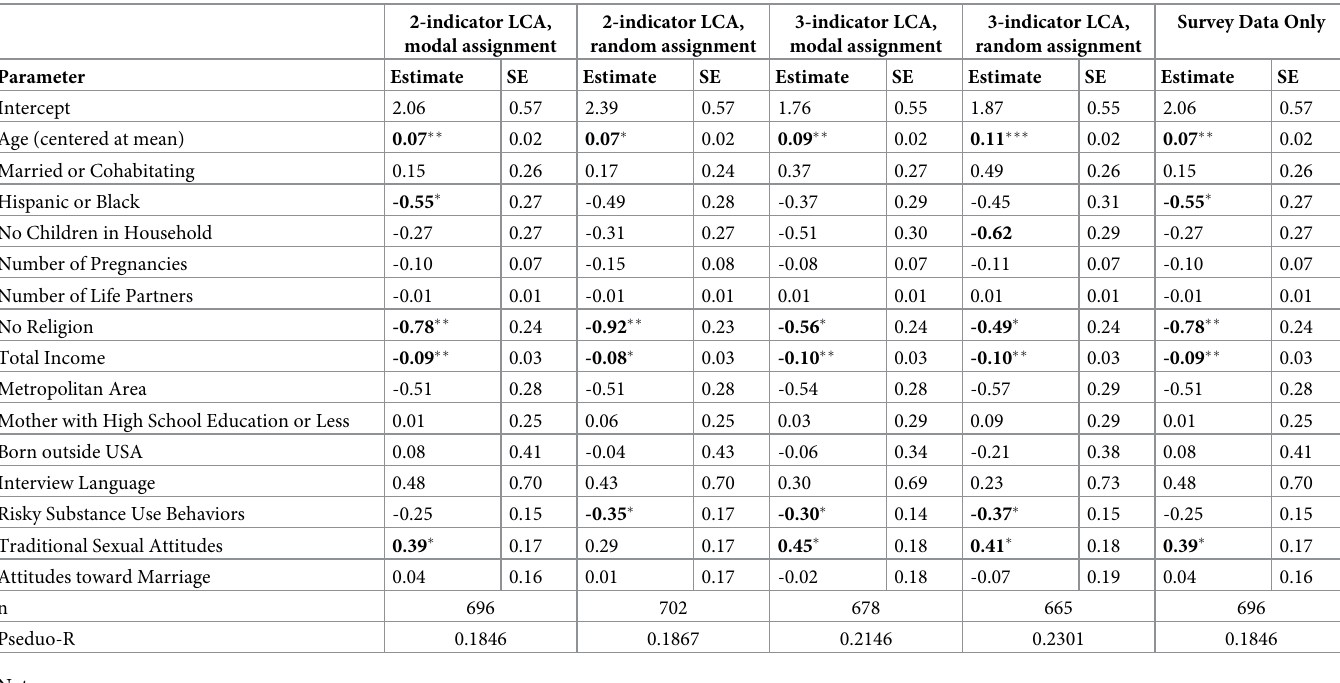
Table 4. Logistic regression coefficients in models predicting underreporting of abortion.